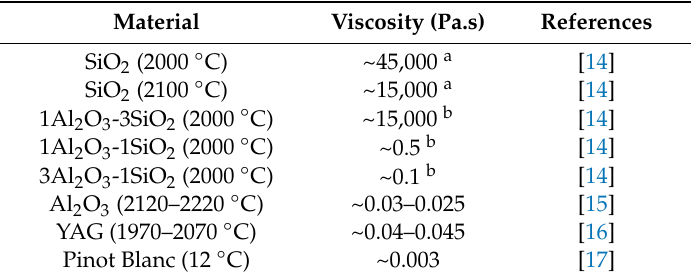
Table 2. Viscosity values for various molten